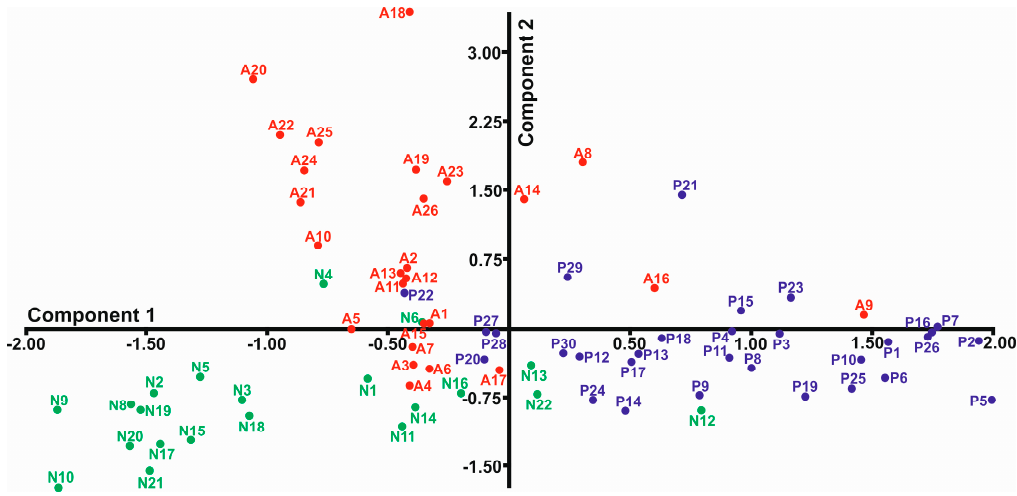
Figure 9. Scatter diagram considering the first two principal components: C1 accounts for about 44% of variance and C2 accounts for about 20% of variance.